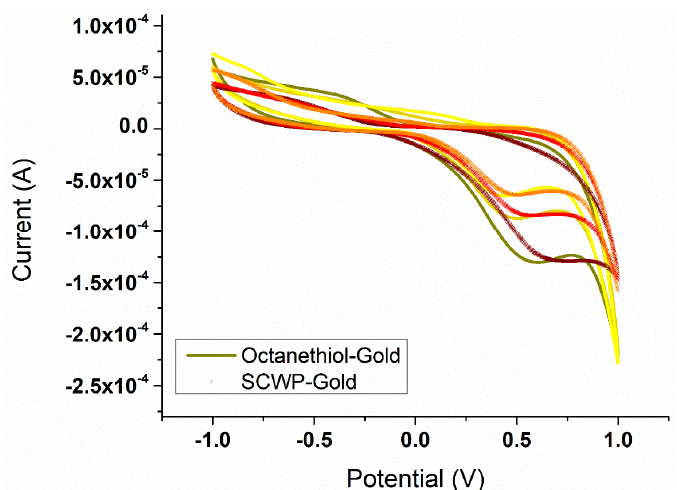
Figure A5. Cyclic Voltammetry measurements ( − 1 to +1 V, 3x cycles) comparing the ion permeability Figure A5 of octanethiol-gold (yellow to green, solid line) and SCWP-gold reference systems (orange to maroon, crosses). Experiments were performed in 0.1M HEPES. Appl. Sci. 2018 , 8 , x FOR PEER REVIEW